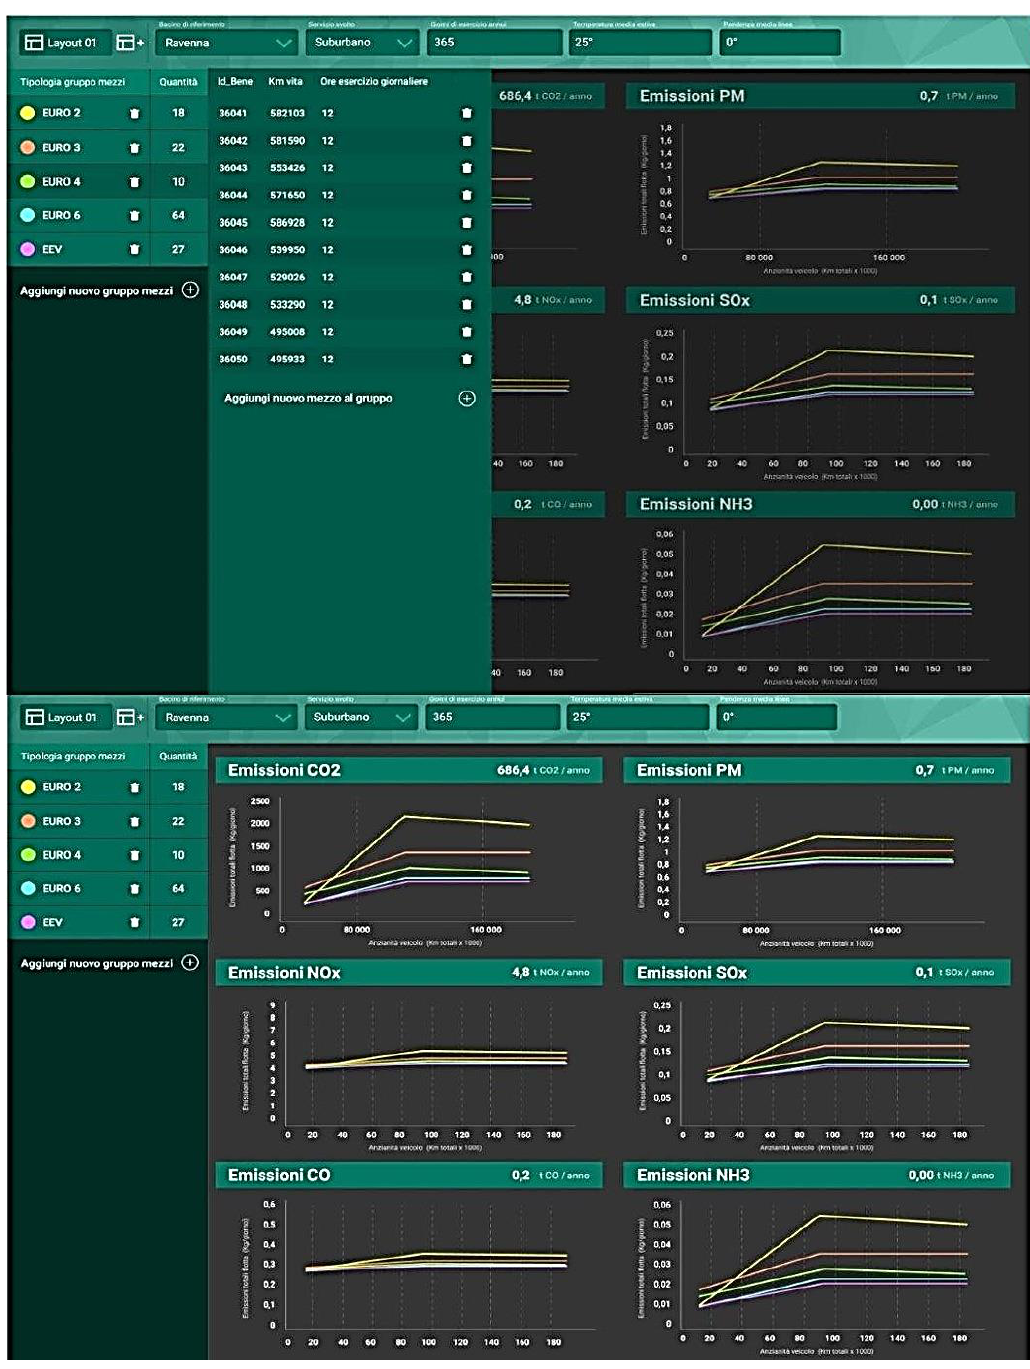
Figure 12. iGREEN interface (mockup).